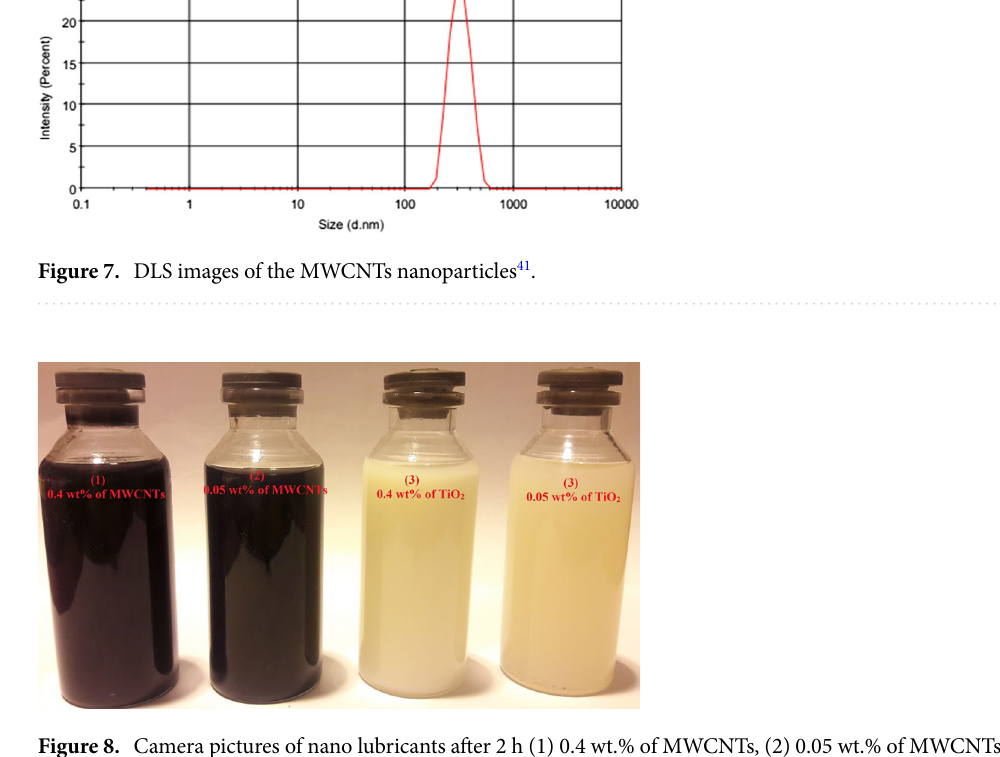
Figure 8. Camera pictures of nano lubricants after 2 h (1) 0.4 wt.% of MWCNTs, (2) 0.05 wt.% of MWCNTs, (3) 0.4 wt.% of